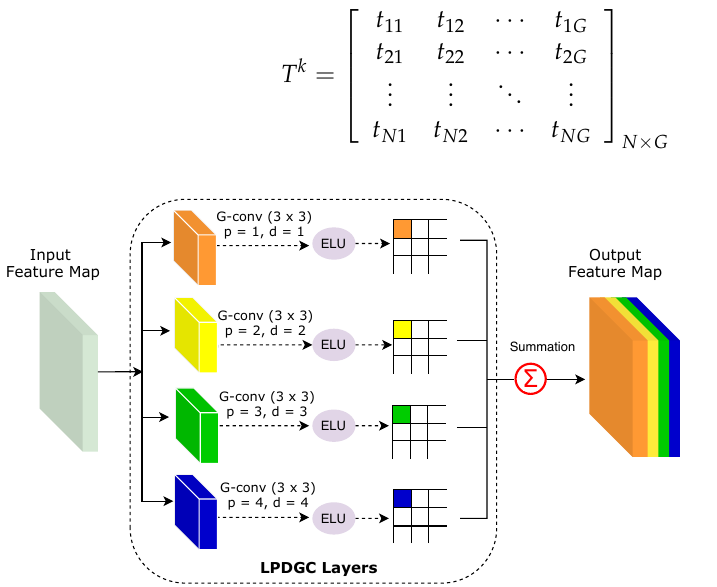
Figure 8. Illustration of the LPDGC block. Here, p and d refer to the padding and dilation rates respectively. ELU refers to the exponential linear unit activation